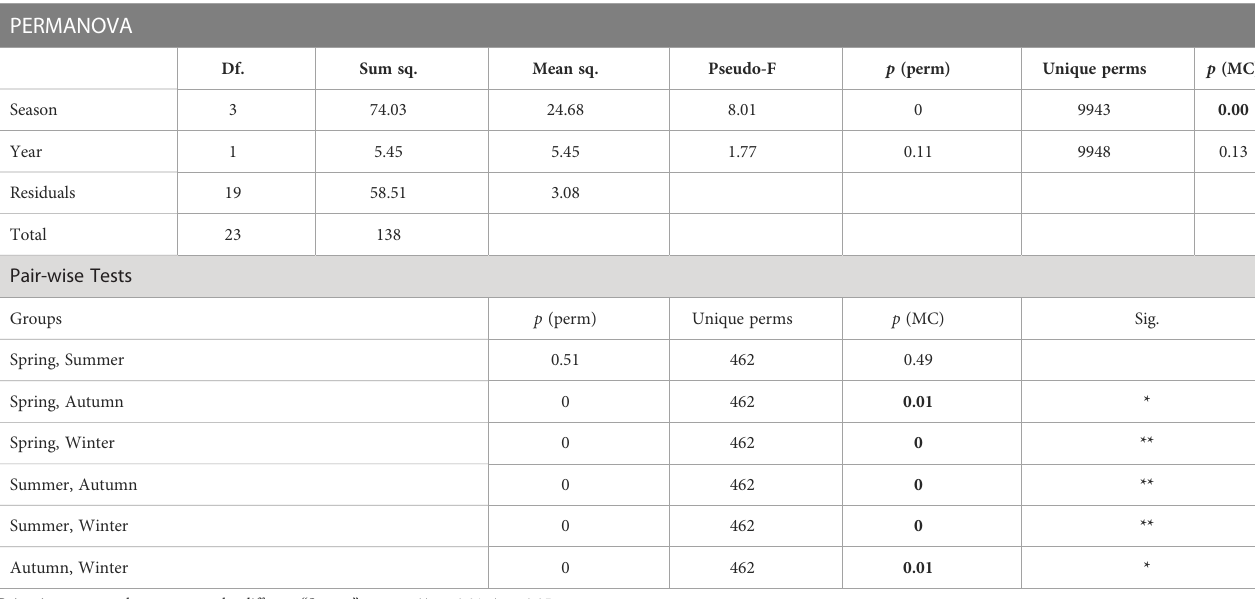
TABLE 3 Permutational multivariate analysis of variance (PERMANOVA) with repeated measures on Euclidean distances for environmental parameters analyzed. PERMANOVA Df. Sum sq. Mean